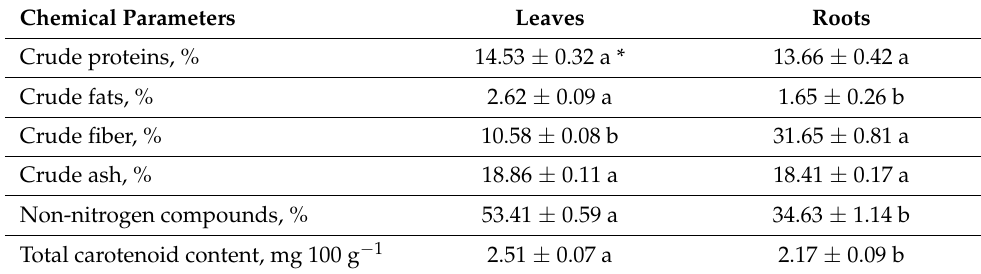
Table 1. Chemical composition of stinging nettle ( Urtica dioica L.) leaves and roots (DM). Chemical Parameters